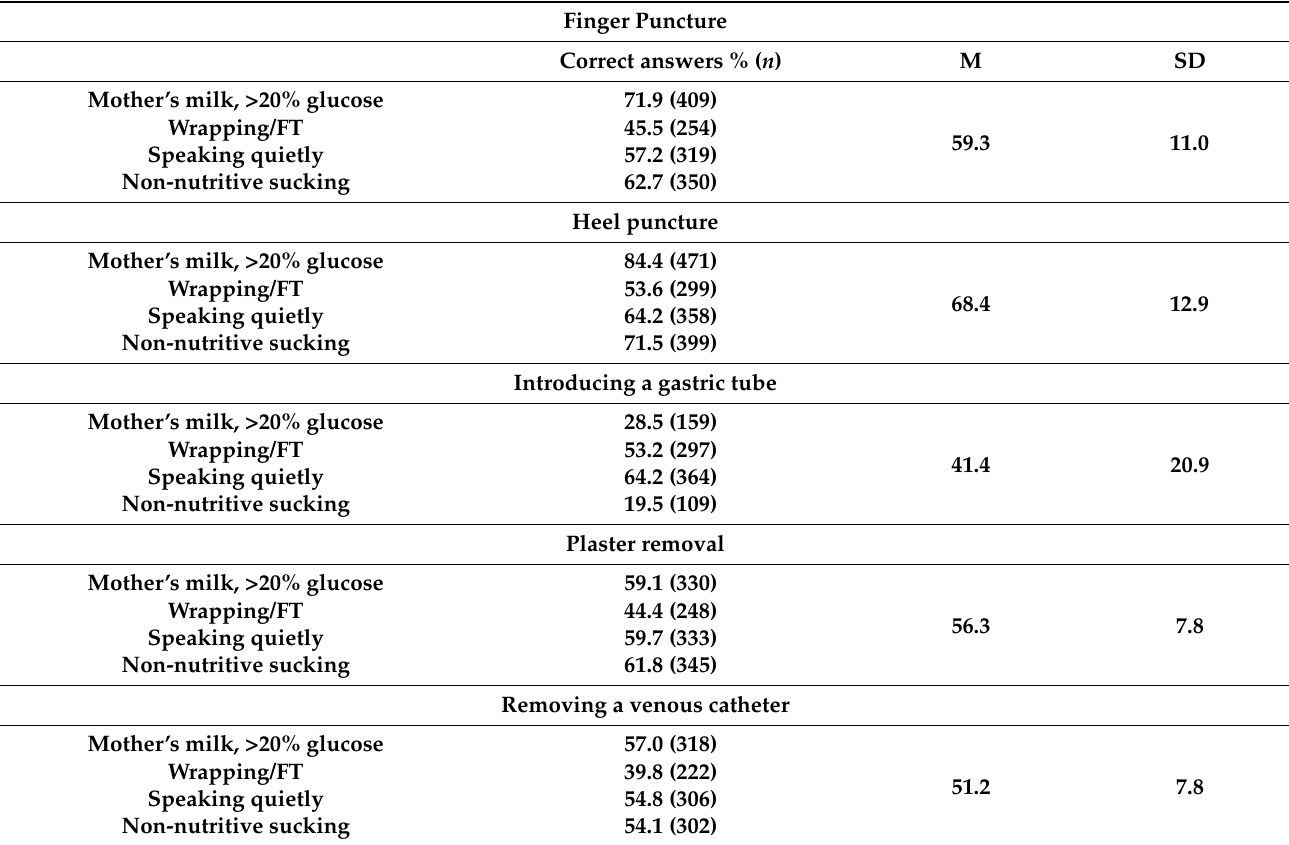
Table 3. The distribution of correct answers given by the respondents with respect to pharmacological and non-pharmacological methods applied in the selected medical